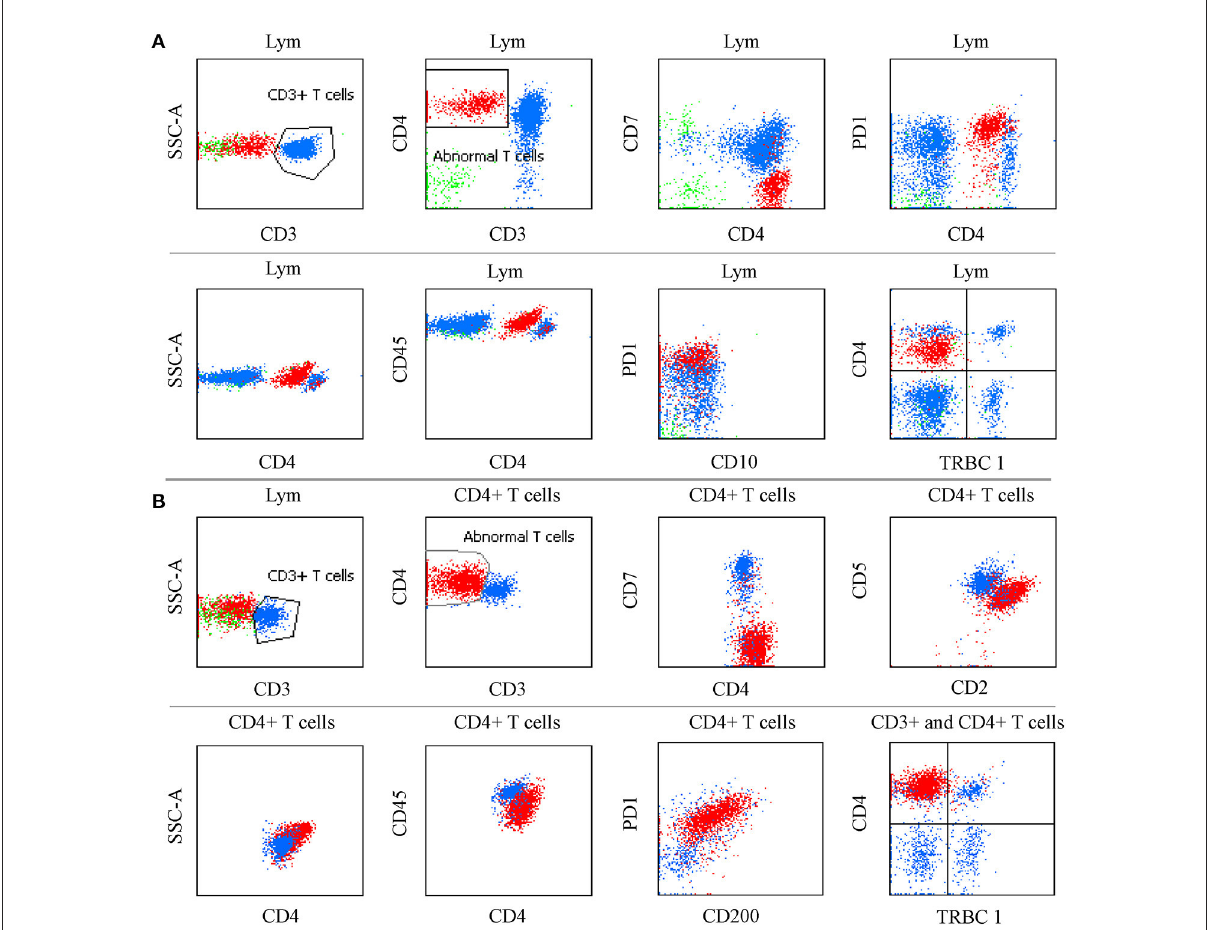
FIGURE2 The most common aberrancies of pan-T cell antigens in AITL. (A) PB specimen in which neoplastic CD4 + T cells had bright CD45 and PD-1 expression, and diminished CD4 expression, lack of CD3, CD7, and TRBC1 with slightly larger side scatter. The same immunophenotyping was observed in BM, PB, and LN specimens. (B) FNA sample in which CD4 + aberrant T cells had bright CD4, CD2, and PD-1 expression, CD200 was positive, CD5, and CD45 were diminished; CD3, CD7, and TRBC1 were absent; Side scatter was